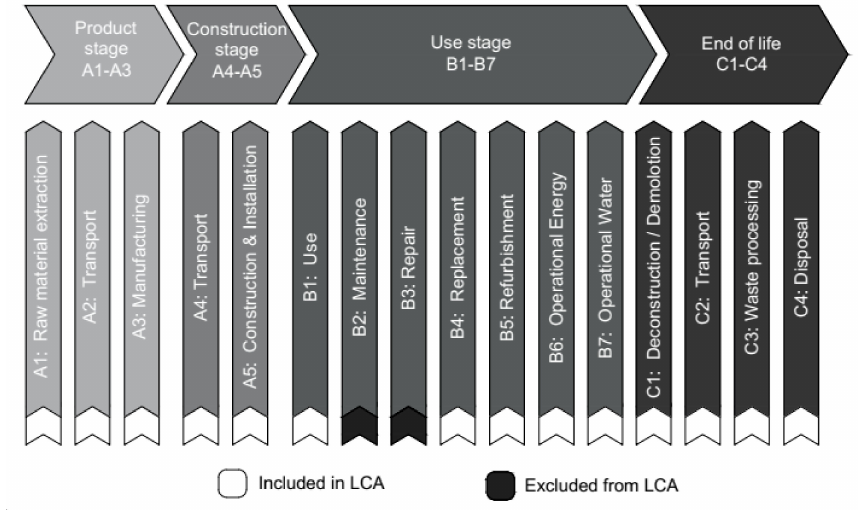
Figure 1. Life Cycle Assessment (LCA) system boundary definition applied to buildings (according to EN 15978).